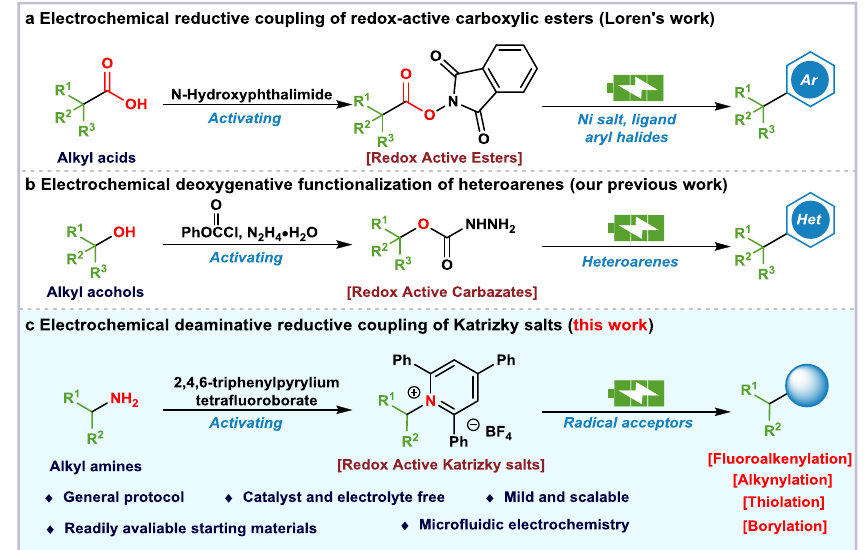
Fig. 1 Electrochemical cross-coupling reactions of activated carbon radicals. a Decarboxylative arylation. b Deoxygenative arylation. c Deaminative